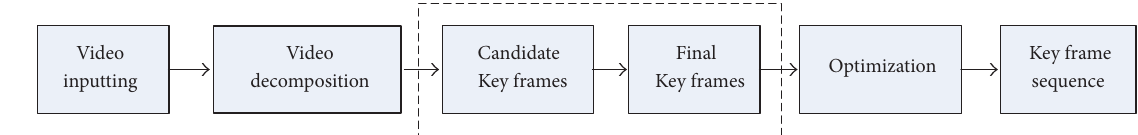
Figure 3: Flowchart of the proposed key frame extraction